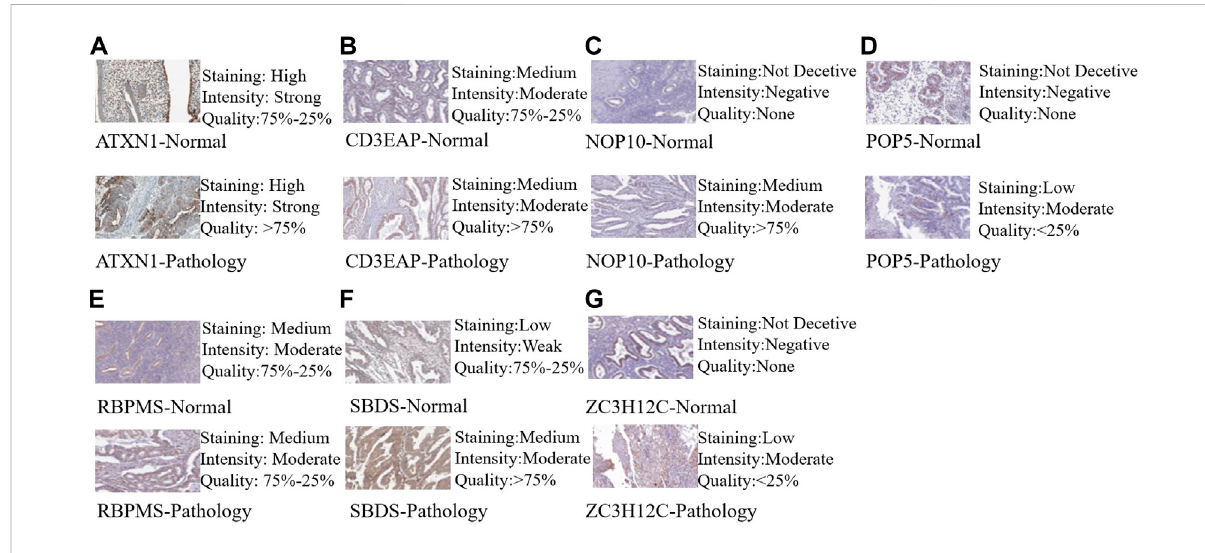
FIGURE 8 Validation of hub RBP expression in UCEC and normal tissue from the HPA database. (A) ATXN1, (B) CE3EAP, (C) NOP10, (D) POP5, (E) RBPMS, (F) SBDS, (G)